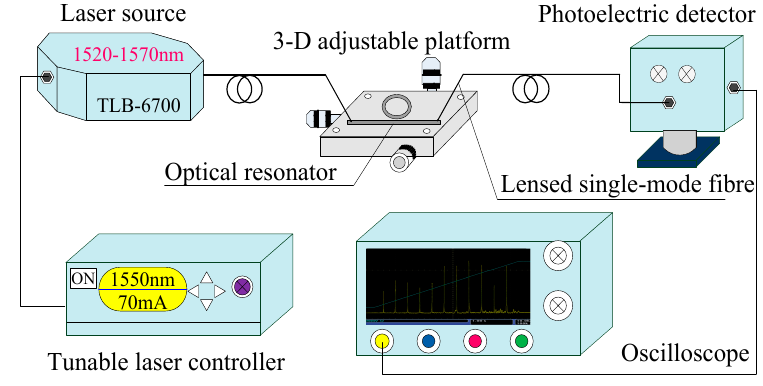
Figure 6. Coupling test